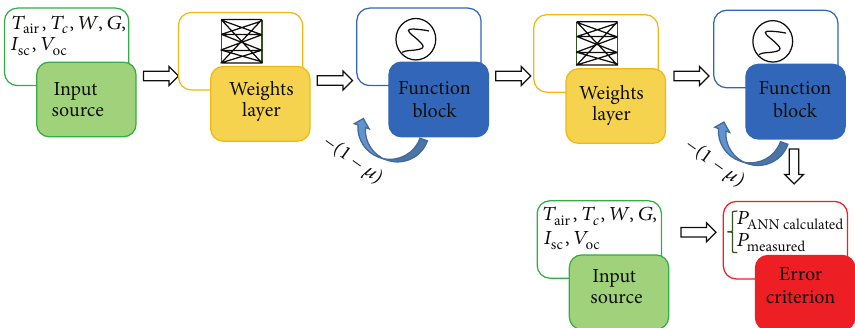
Figure 10: Schema of RNN MLP topology for the power output evaluation.